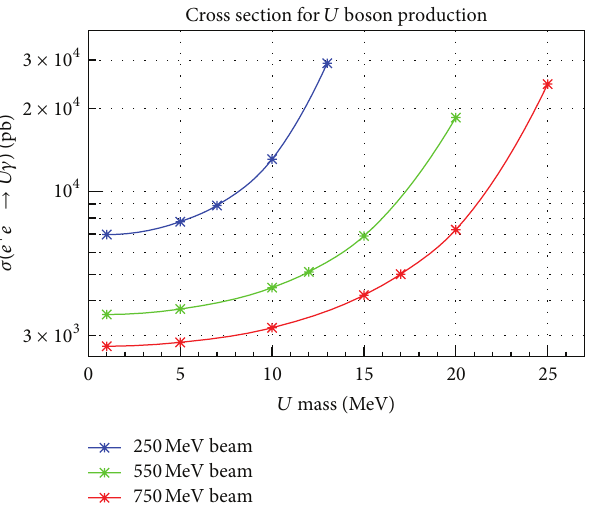
Figure 8: 𝑈 boson production cross section (for 𝜖 = 10 −3 ) as a function of mass for different beam energies.